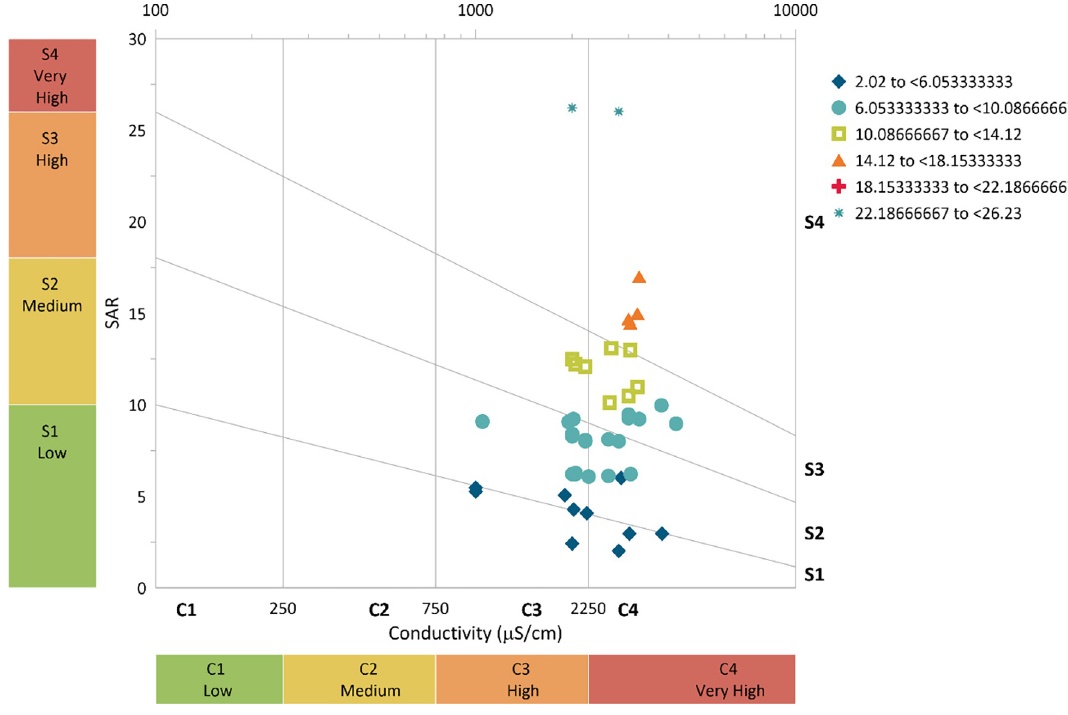
Fig 8. Salinity hazard from raw